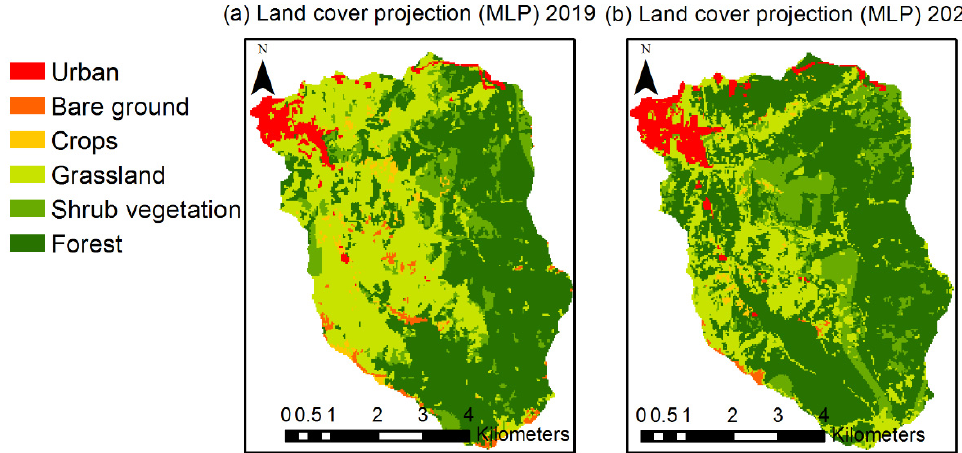
Figure 3. Maps projected with neural networks (MLP) for ( a ) 2019 and ( b ) 2029. Map (c) in Figure 2 represents LULC of scenario (1); map (b) in Figure 3 contains LULC of scenario (2). When analyzing the coverage extension, it is evident that the forest area is the most abundant, occupying in the basin 54.81% of its total extension for the year 2019, while on projection for 2029 it occupies 58.72%, so an increase of 3.91% is evident.